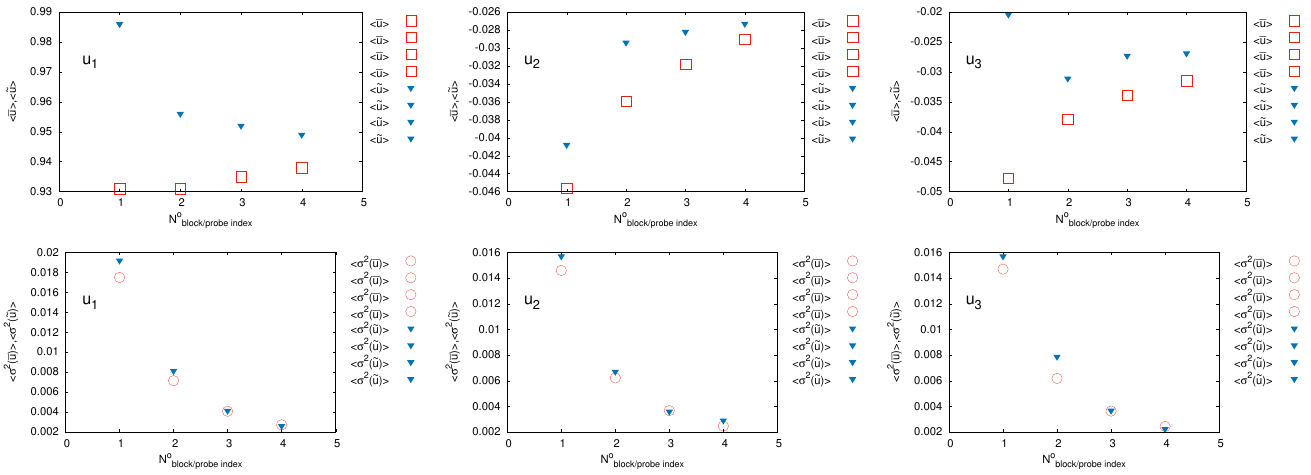
Figure 13. Comparison of non dimensional mean velocity u i / u ∞ and variance σ 2 for all velocity components by spatial averaging on sub-blocks 1 to 4 ( top ) and by time averaging at probes P 1 to P 4 ( bottom